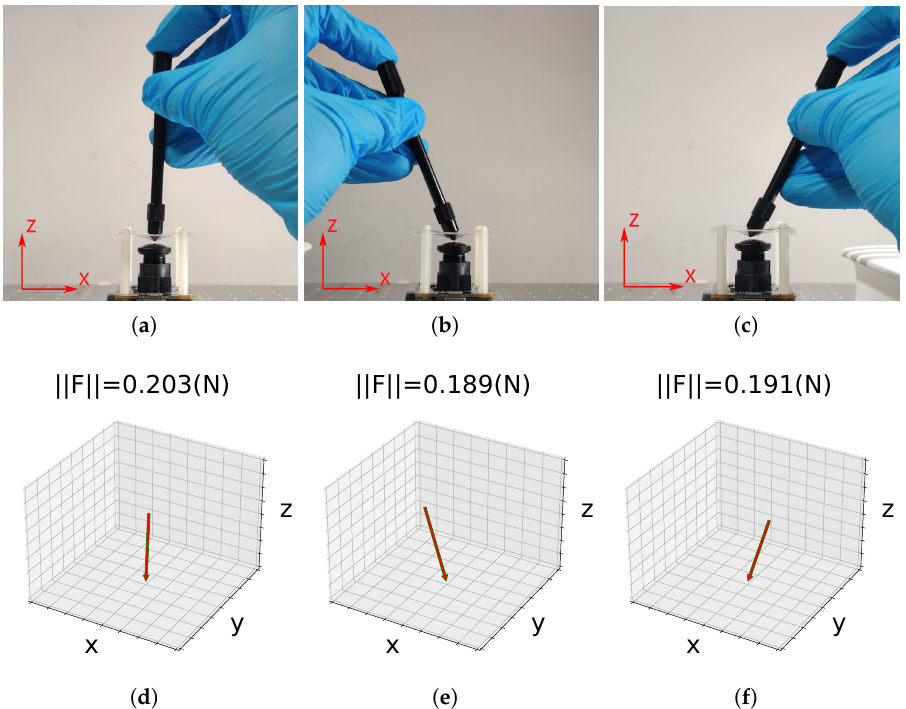
Figure 16. A demonstration of real-time reconstruction. A stick with a cone attachment was used to press the center of the elastic layer of the proposed device from the ( a ) normal, ( b ) left, and ( c ) right directions. Their reconstruction results, including magnitude and direction, are plotted in ( d – f ), respectively. Notice that the z direction here is opposite to that in Figure